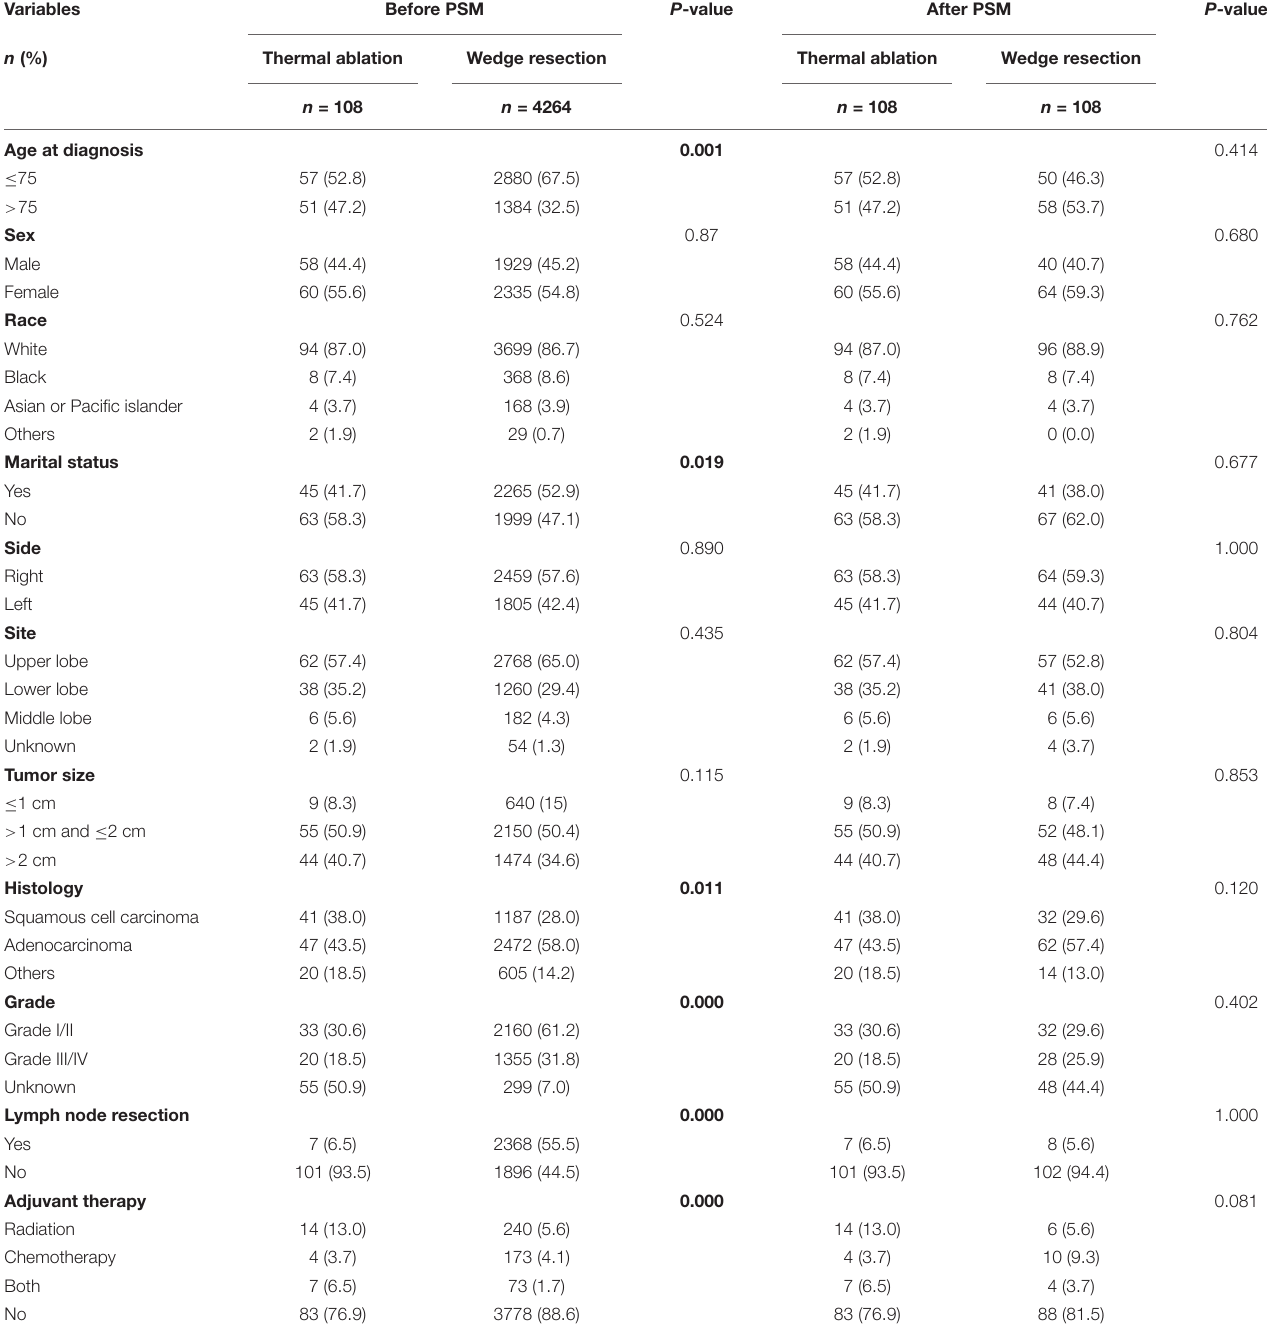
TABLE 1 | Characteristics of stage I NSCLC patients from SEER Database from